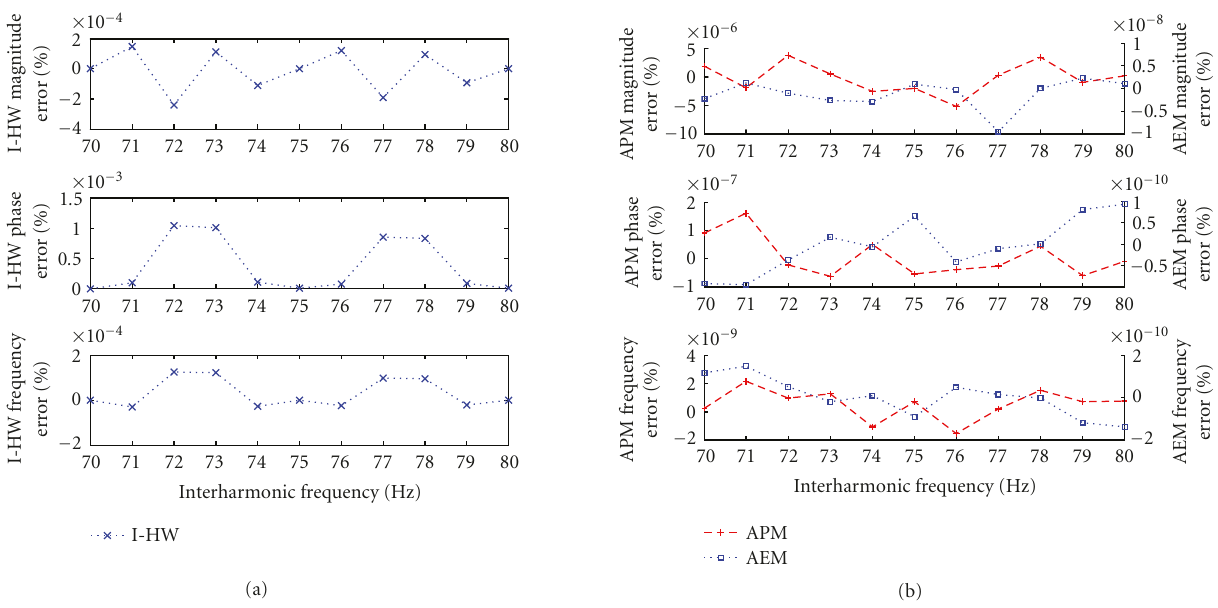
Figure 5: Case study 1: interharmonic amplitude, phase angle, and frequency error (in %) versus interharmonic frequency: (a) I-HW (dotted line x ), (b) APM (dotted line +) and AEM (dotted line (cid:3) ).